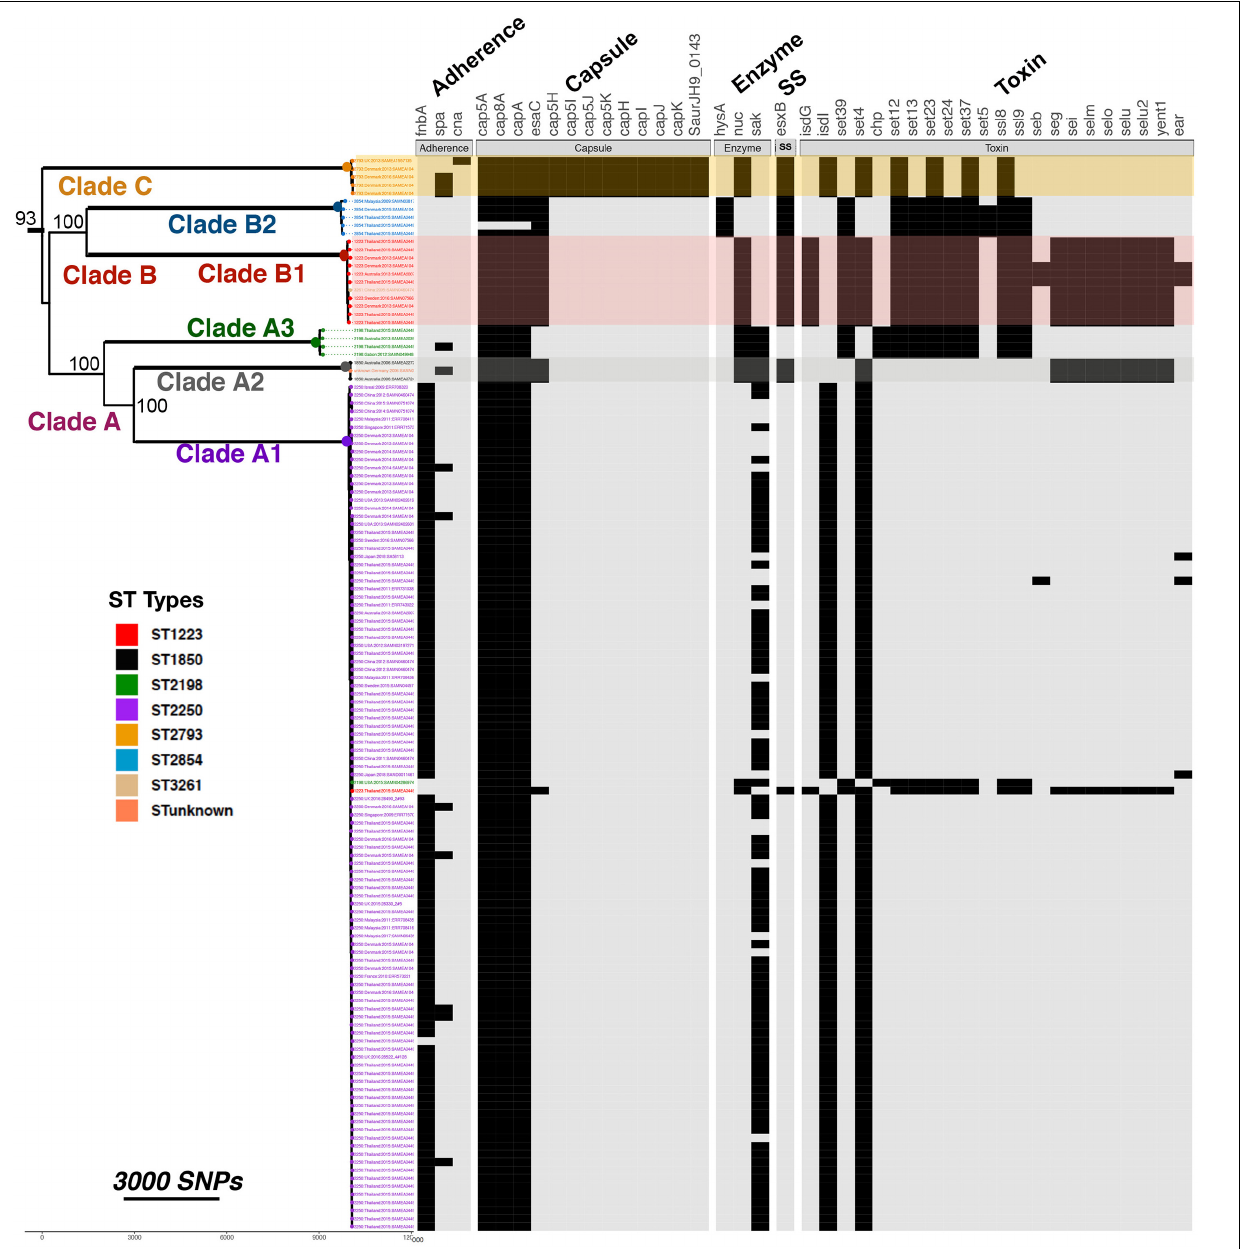
FIGURE 3 | Comparison of virulence gene content in different STs. The presence and absence of specific virulence genes within each isolate are shown by black rectangles. Genes are grouped according to their broad functions as shown. SS indicates secretory system. The phylogenetic tree shows relationships between the strains based on core gene SNPs. Bootstrap support for the major clades is shown from 1,000 bootstrap trees. The scale bar shows the number of SNPs corresponding to branch length.